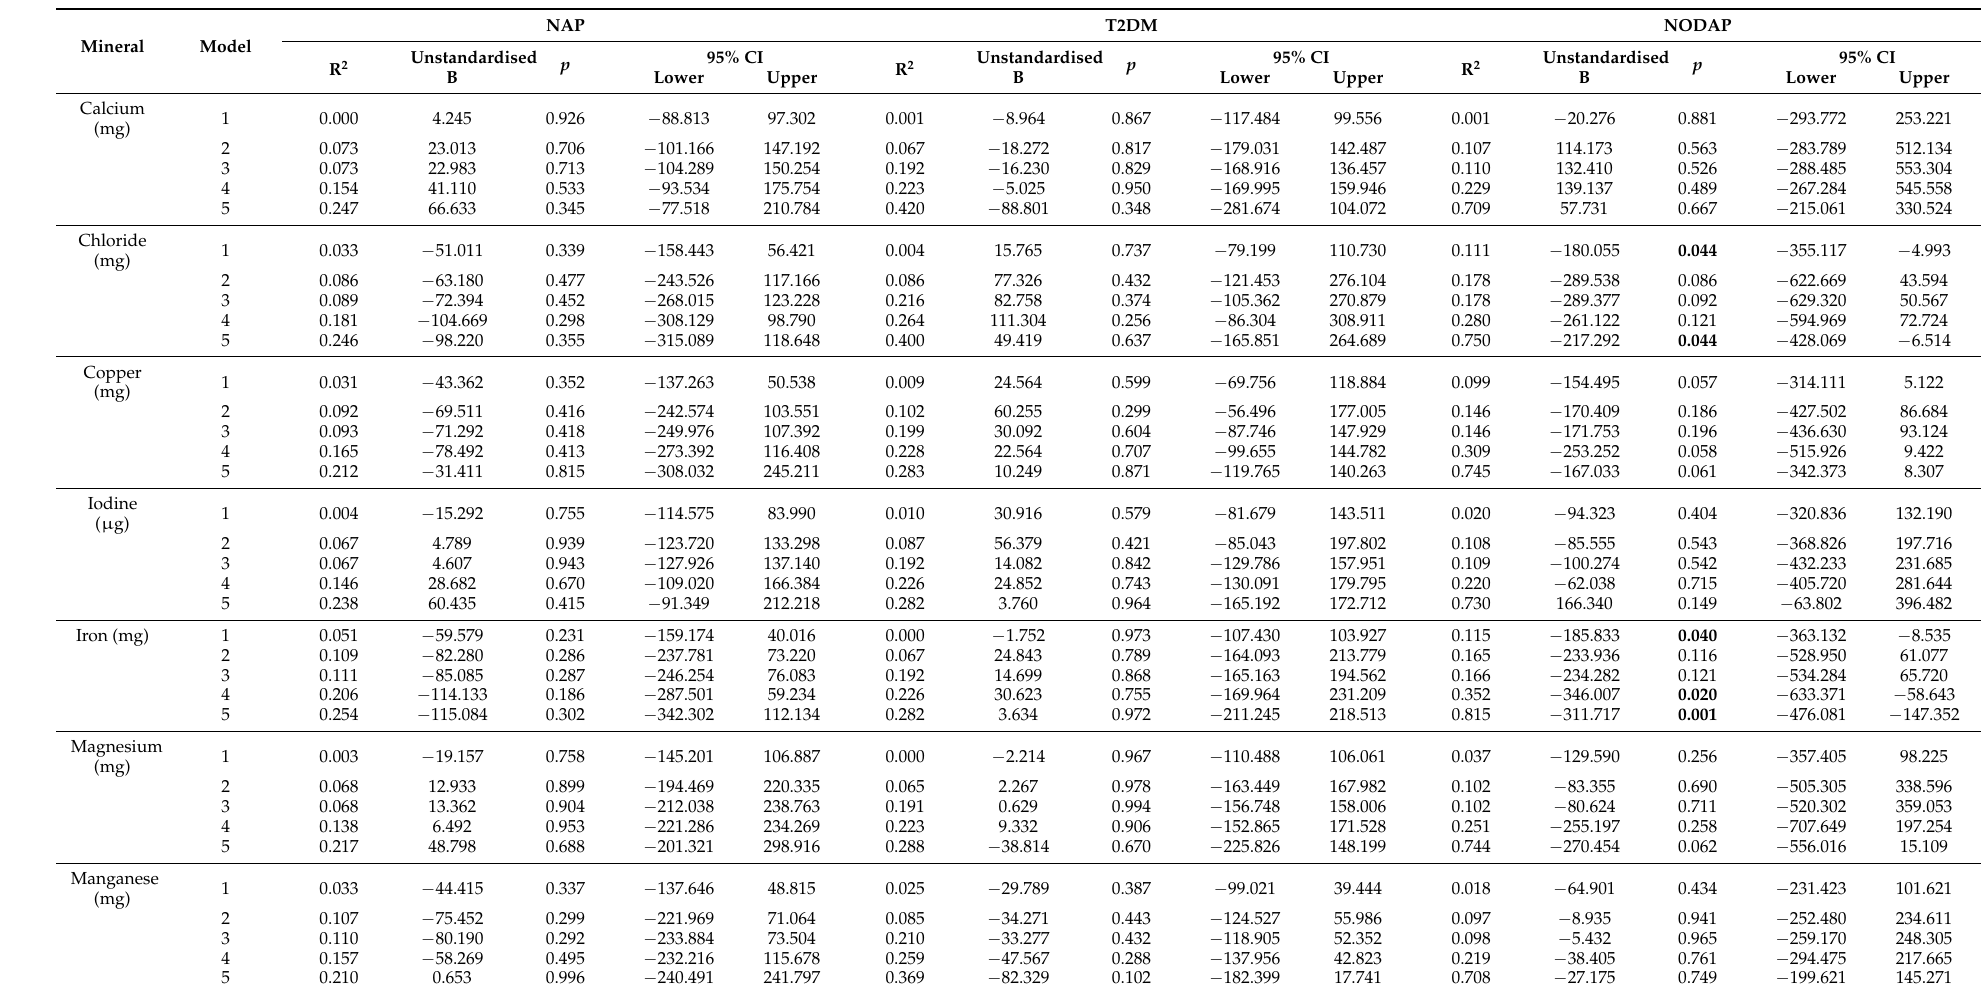
Table 6. Associations between habitual mineral intake and HOMA-S in the study